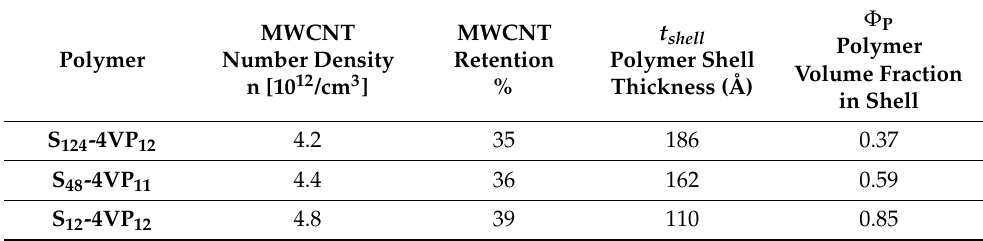
Table 9. The fitted parameters obtained from fitting procedures of SANS data of MWCNT/polymer dispersions with copolymers of different PS molecular weights, in 10 and 100 wt.% DMF-d7